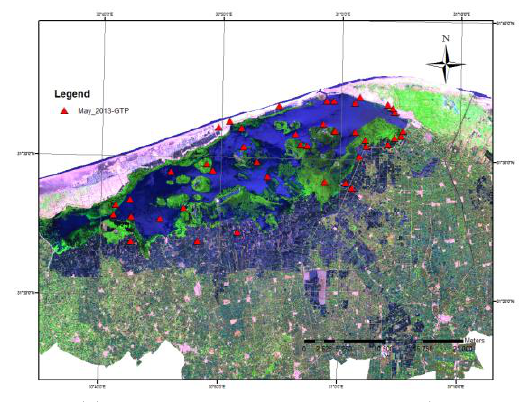
Figure (2) Ground truth points distribution (Image date, May 2013)